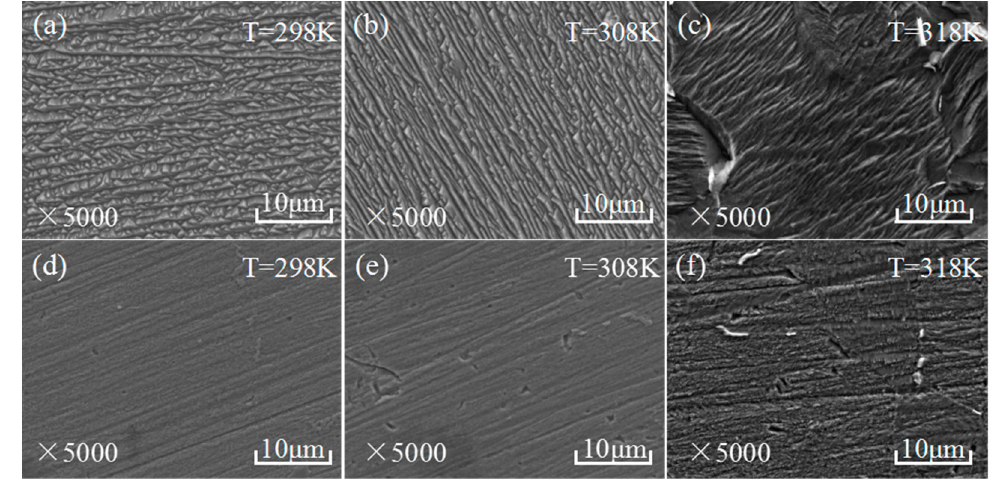
Figure 10. SEM images of the C-steel surface after immersion in 1 M HCl for 1 h: ( a ) at 298 K; ( b ) at 308 K; ( c ) at 318 K; ( d ) containing 0.5 g·L − 1 EJTLE at 298 K; ( e ) containing 0.5 g L − 1 EJTLE at 308 K; and